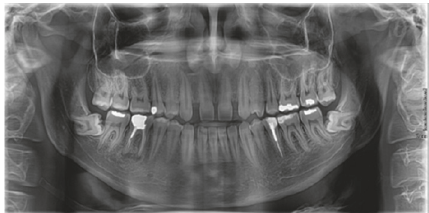
Figure 1: A panoramic radiograph of a patient with bilateral